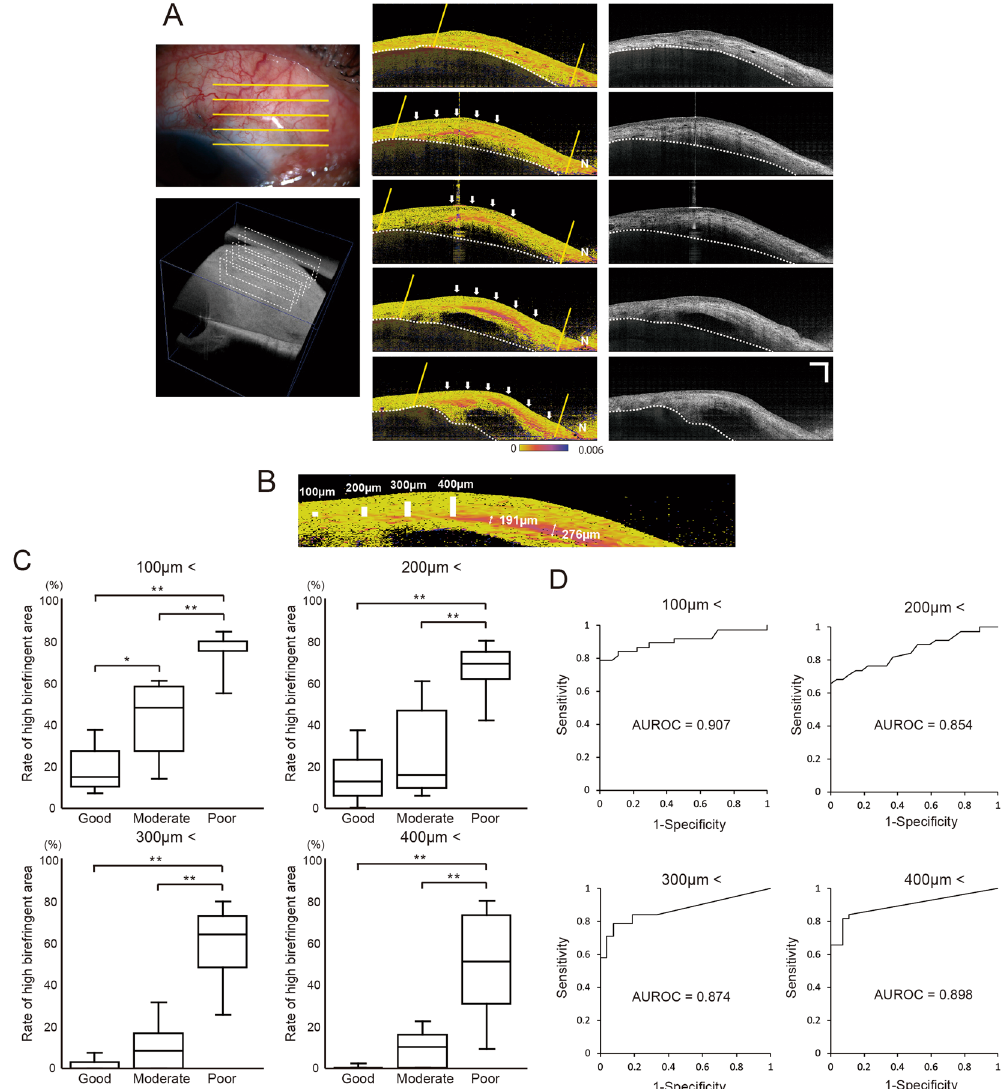
Figure 5. Relation between plate-like birefringence change and bleb function. ( A ) Five cross sections of local birefringence images are obtained and submitted to polarization-sensitive optical coherence tomography. The areas of the bleb and plate-like birefringence changes are measured. Thicken conjunctiva are defined as a bleb area. Strong signal noise area is excluded from bleb area (N). Final bleb area is comprehensively judged by using anterior photograph and cross section intensity images. The white dotted line delineates the boundary between the conjunctiva and sclera. Inside of two yellow line indicates bleb area. White arrow indicates plate-like fibrotic change. N: noise area. Sclera is covered with a semitransparent black shadow. Scale Bar, 1 mm. ( B ) Sample of thickness of plate-like fibrotic change. Scale bars: 100 µ m, 200 µ m, 300 µ m and 400 µ m. ( C ) Each definition of plate-like fibrotic change area as thicker than 100 µ m, 200 µ m, 300 µ m, or 400 µ m, the percent of area of plate-like birefringence change in regard to the whole bleb area. ( * p < 0.005, ** p < 0.0001, analysis of variance with the Bonferroni correction). ( D ) Each definition of plate-like fibrotic change area as thicker than 100 µ m, 200 µ m, 300 µ m, or 400 µ m, receiver operating characteristic (ROC) curve analyses for the comparison of the discrimination ability of bleb function. The “moderate” or “poor” bleb functions are considered as positive, and the “good” bleb function is considered as negative. The values of the area under receiver operating characteristic (AUROC) are also